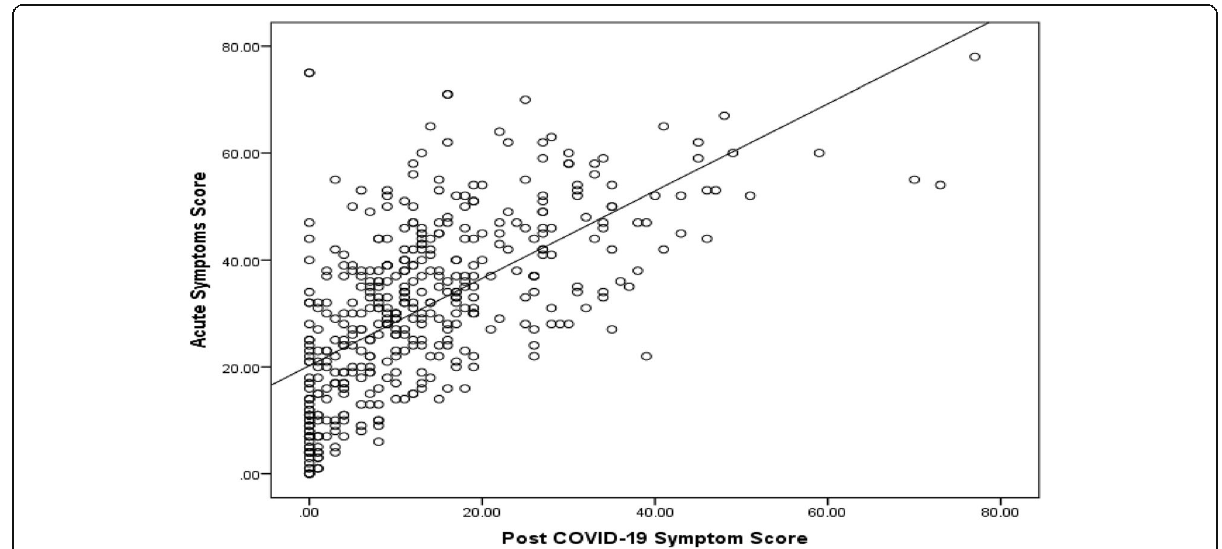
Fig. 3 Correlation between symptom score during acute and post-COVID-19